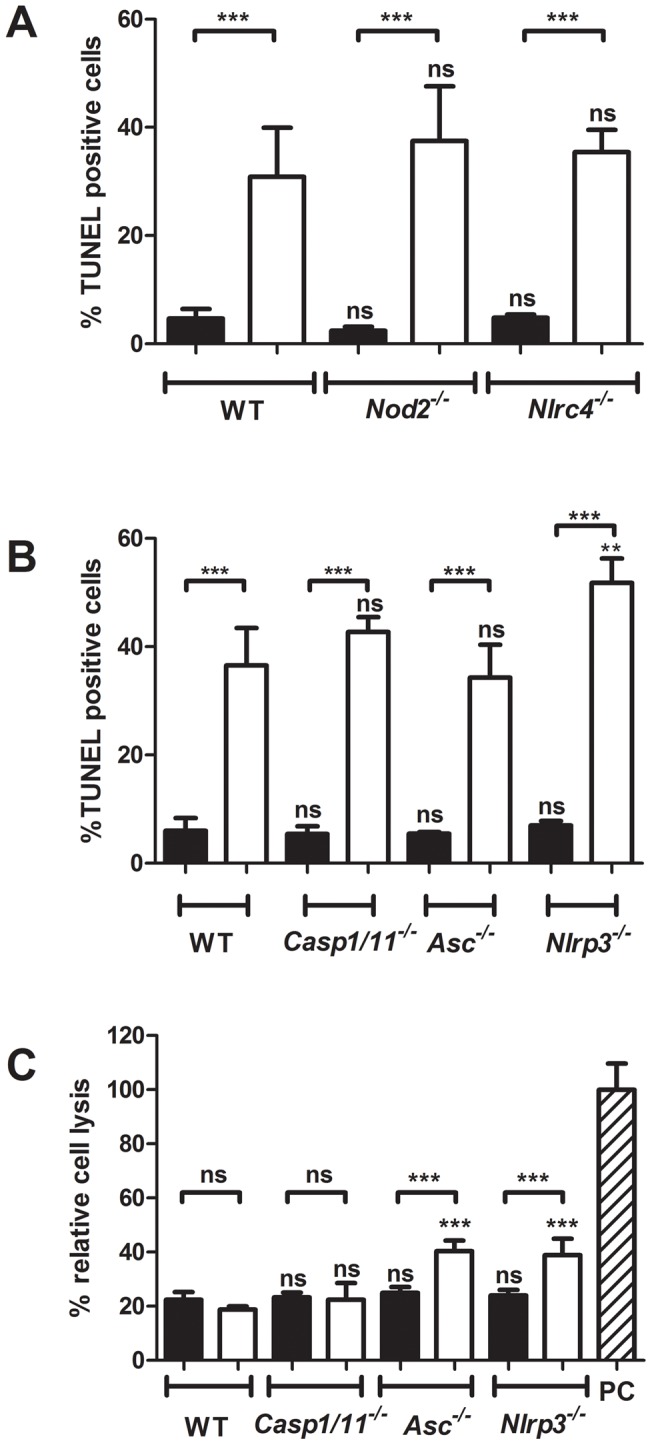
The inflammasome is not involved in BMDC host cell death induction after Mtb infection.BMDCs from indicated wild-type or knockout mouse strains were infected with Mtb (white bars) or left uninfected (black bars). After 24 h the amount of TUNEL positive cells was determined in (A) and in (B). In (C) the amount of necrosis was determined via analysis of the release of adenylate kinase into the supernatant of infected cells relative to detergent lysed cells (PC). Shown are means and standard deviation of triplicate measurements of one representative experiment out of three.